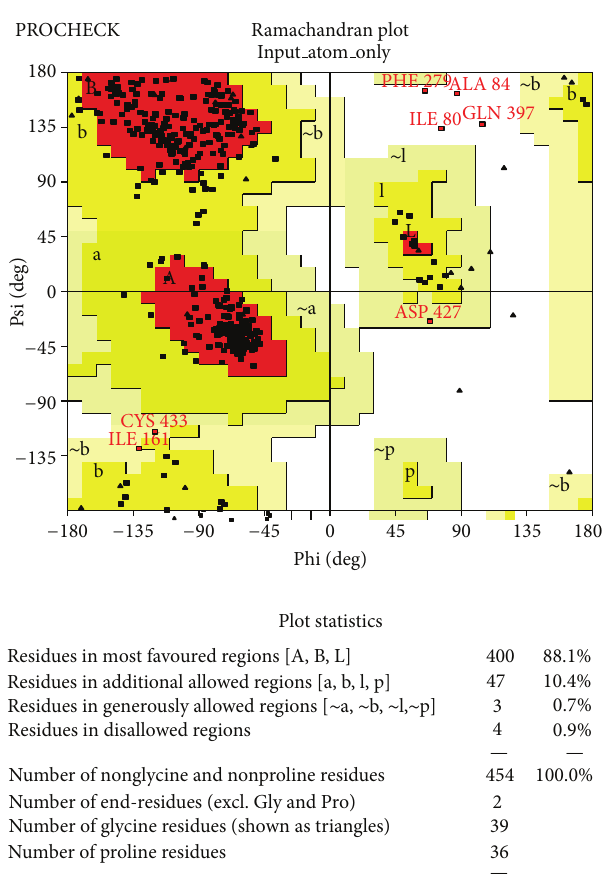
Figure 4: Ramachandran plot of the modeled structure of tomato 𝛽 - 𝑁 -acetyl hexosaminidase provided by PROCHECK.